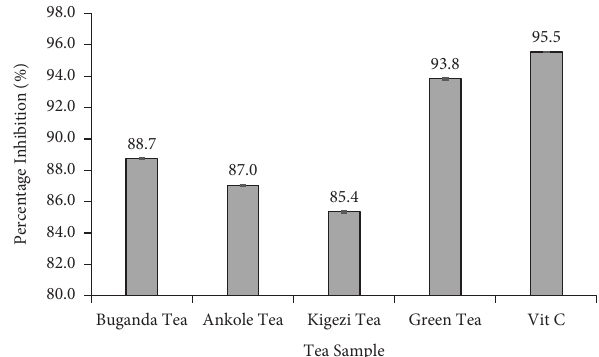
Figure 1: DPPH percentage inhibition of black tea from diferent regions and green tea.